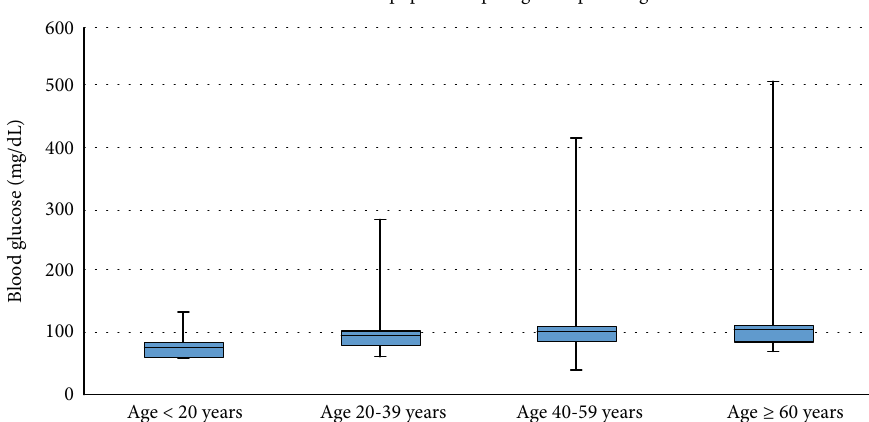
Figure 2: Population classi fi cation by age and mean plasma